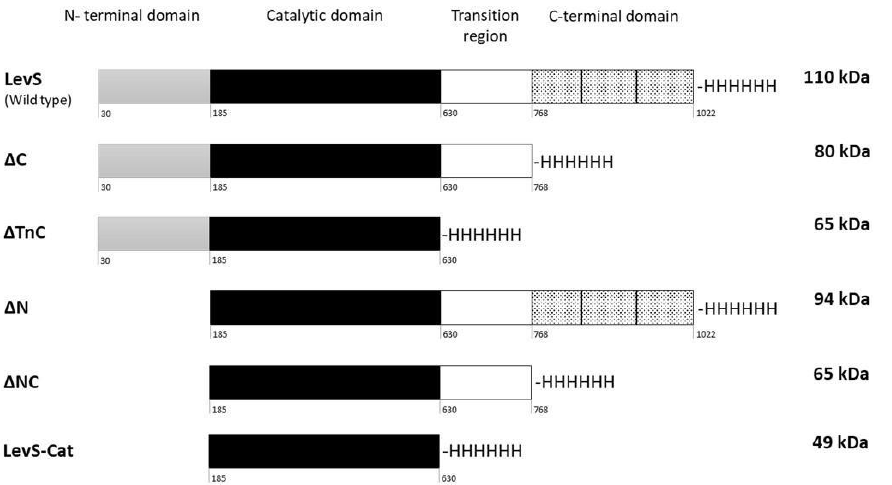
Figure 1. Schematic representation of LevS and truncated forms. LevS: complete mature enzyme; LevS ∆ C: deletion of the C-terminal domain; LevS ∆ TnC: deletion of the transition region and the C-terminal domain; LevS ∆ N: deletion of the N-terminal domain; LevS ∆ NC: deletion of both N- and C-terminal domains; LevS-Cat: presence only of the catalytic domain. All proteins contain a histidine tag at the C-terminus.